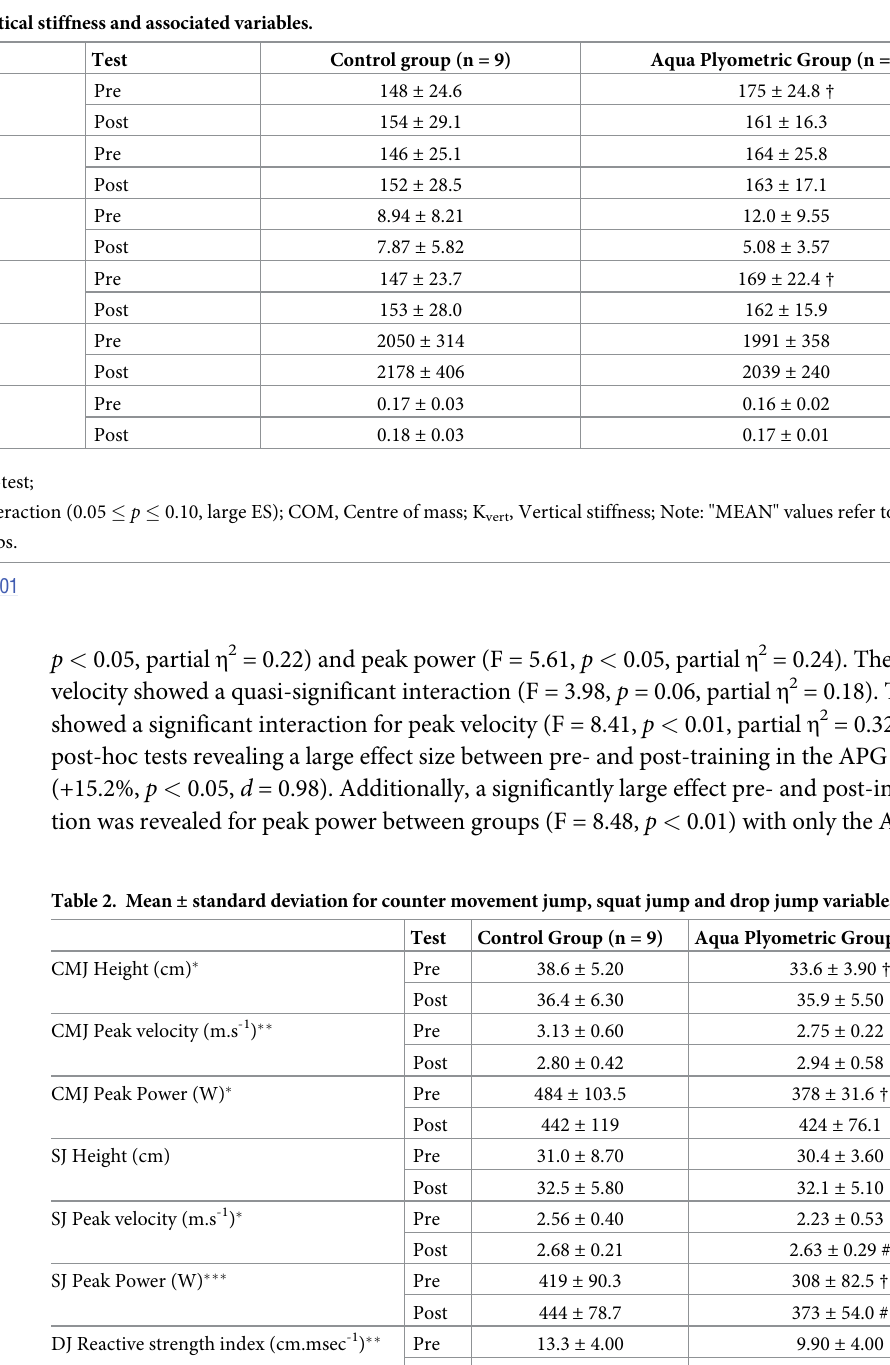
Table 1. Mean ± standard deviation for vertical stiffness and associated variables.